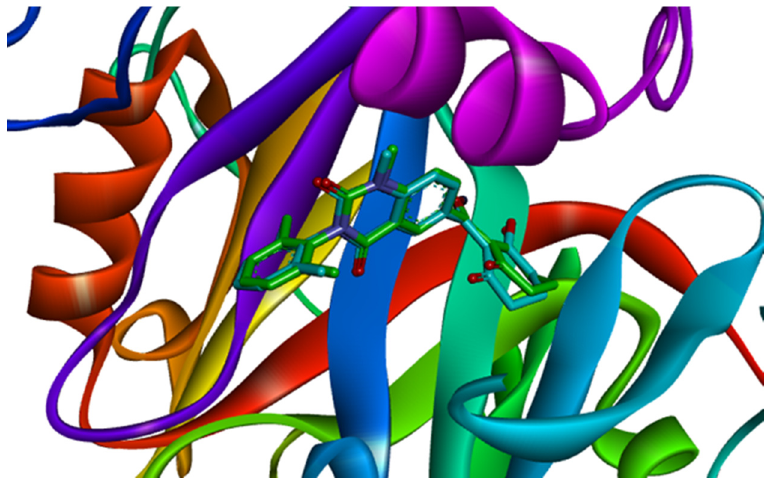
the crystallographic complex was blue.